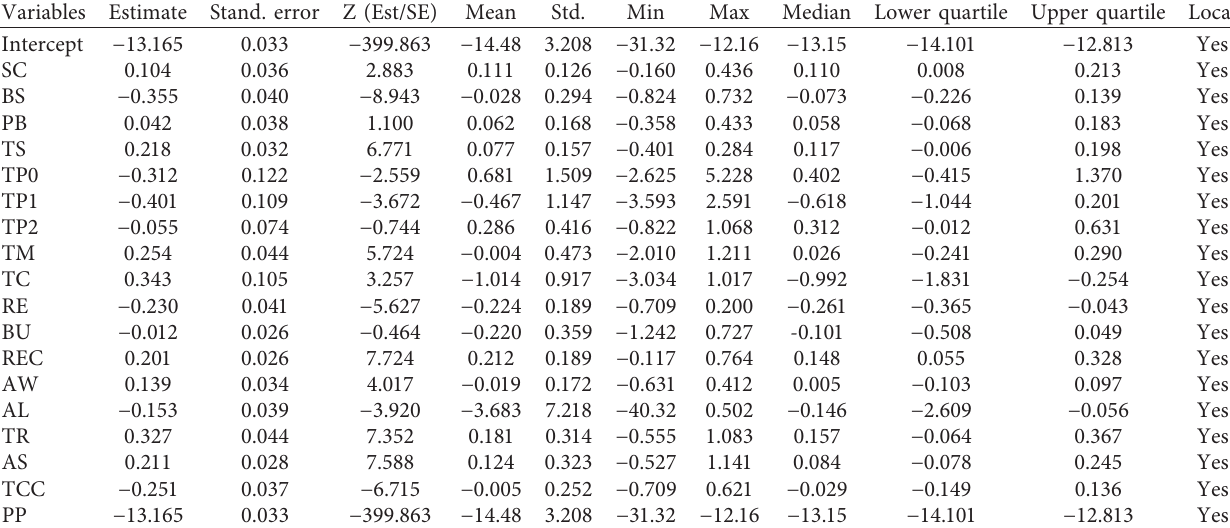
Table 7: Summary results of the GWPR model for predicting crash. Variables Estimate Stand. error Z (Est/SE)